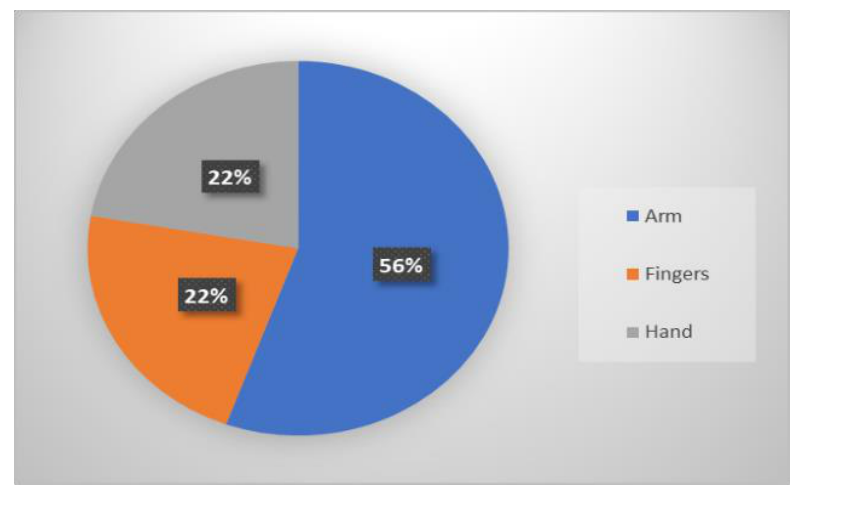
Figure 7 – EEG signal control in the robotic arm research studiesfrom Table 4 Рис. 7 – Управление сигналом ЭЭГ в исследованиях роботизированной руки из Таблицы